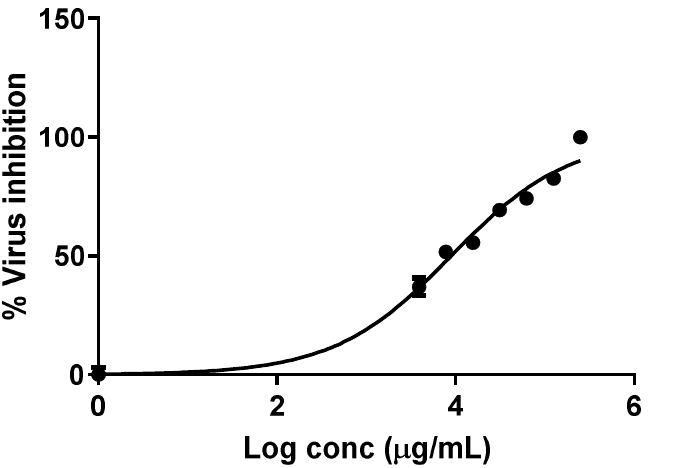
Figure 5. Antiviral activity of Salvadora persica methanol extract (IC 50 of 8.946 ± 0.02 µg/mL) against the HSV-2 virus. The results are presented as the mean ± SD.